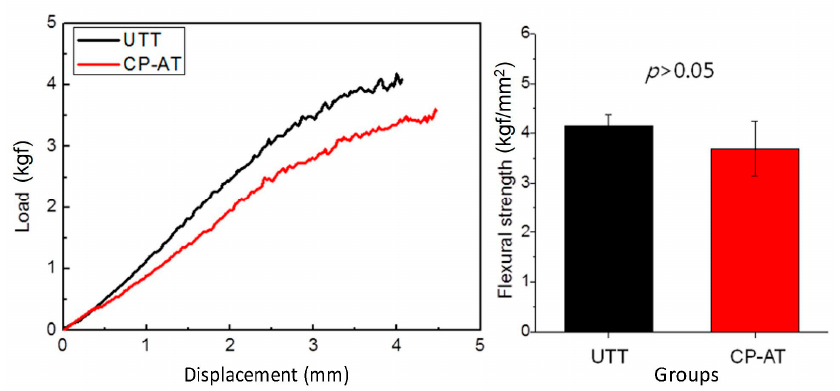
Figure 3. Bioactivity of biphasic ceramic immersed in SBF at 37 °C for three days. Precalcified biphasic untreated biphasic ceramic (BC) did not show any changes on the surface ( C , D ).